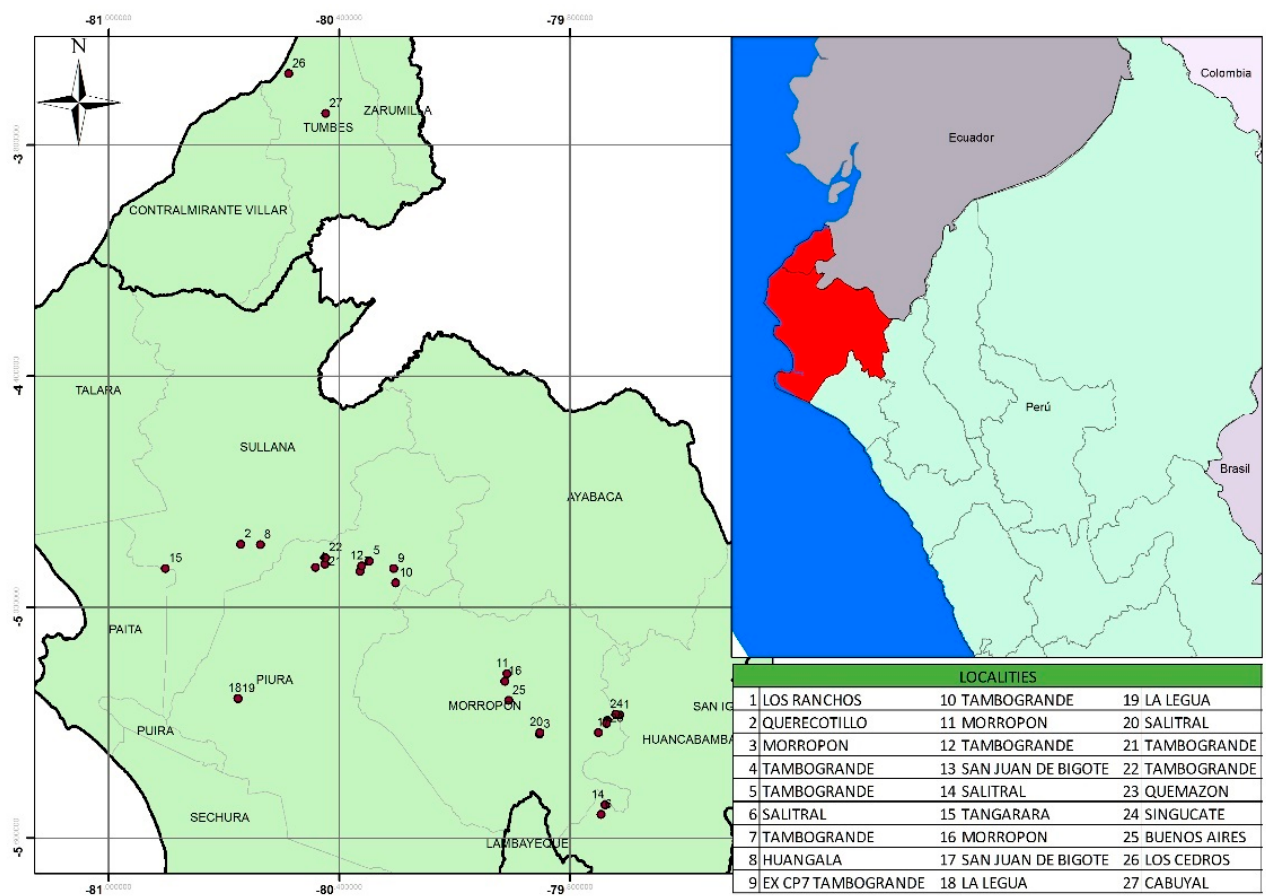
Figure 1. Current peacock mite Tuckerella pavoniformis distribution in north–western Peru.